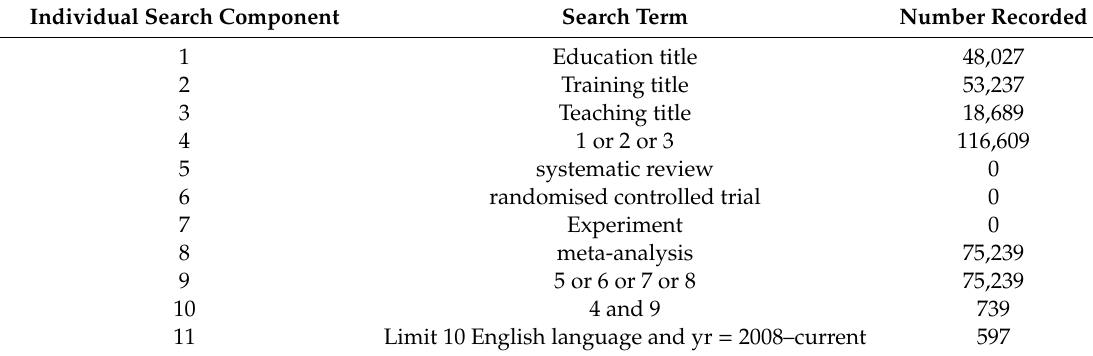
Table A1. Example search strategy (MEDLINE) for the rapid review of health professional training shown to improve clinical practice.